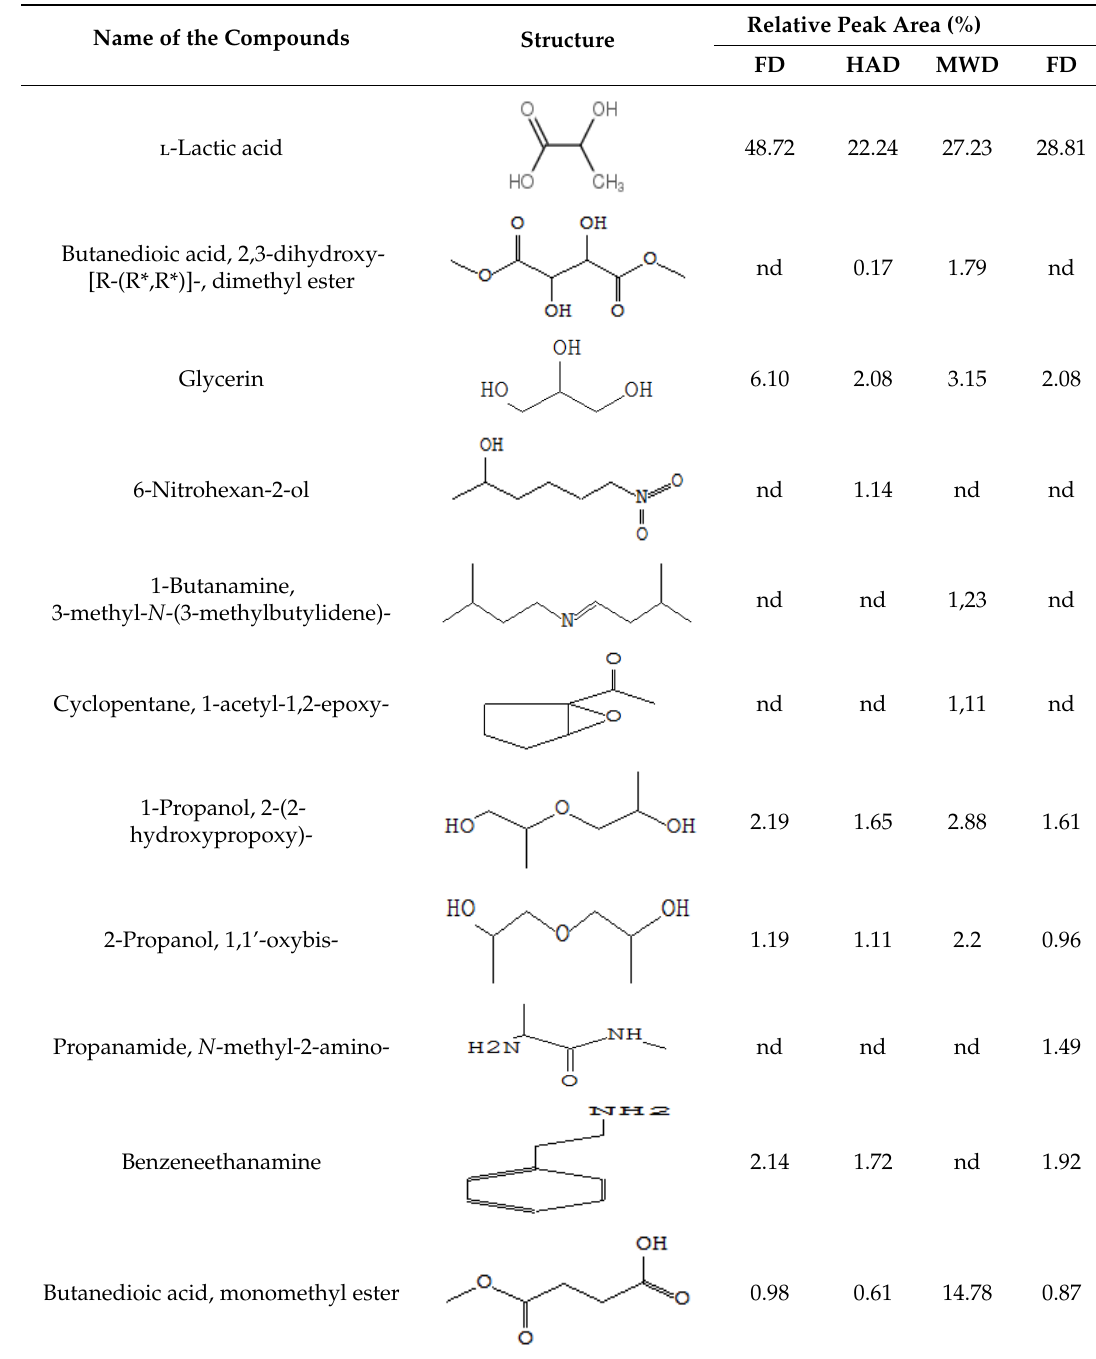
Table 3. Profile of secondary metabolites of dry fruiting bodies Pleurotus ostreatus (based on the results of gas chromatography-mass-spectroscopy) after in vitro digestion.